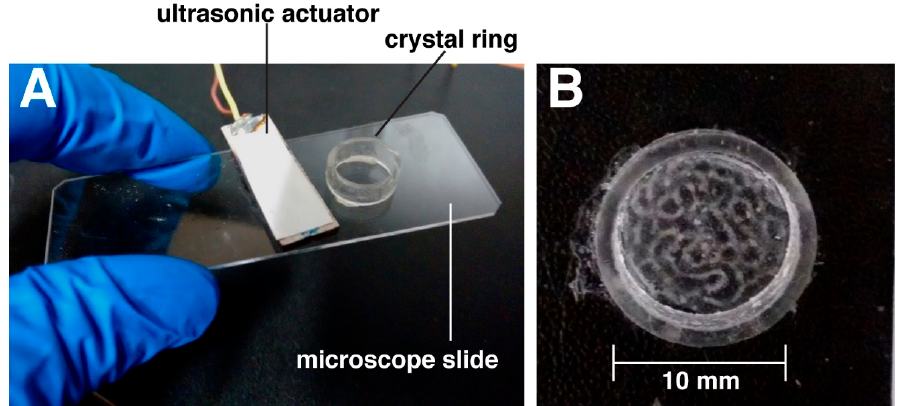
Figure 1. ( A ) Photograph of the ultrasound exposure system. A cylindrical open chamber was formed using a crystal ring (with an inner diameter of 10 mm, wall thickness 1 mm, height 4 mm) glued onto a microscope slide. The cavity was activated by an ultrasonic actuator; a small piezoelectric ceramic Ferroperm pz26 of rectangular area (30 mm × 15 mm × 1.5 mm), resonant at a frequency close to 1 MHz, was placed also on the microscope slide and close to the chamber of treatment. ( B ) 3D acoustic pressure pattern formed inside the acoustic cavity when a continuous wave at f = 1009 kHz (resonance frequency) and a fixed voltage of V P - P = 10 V is applied.